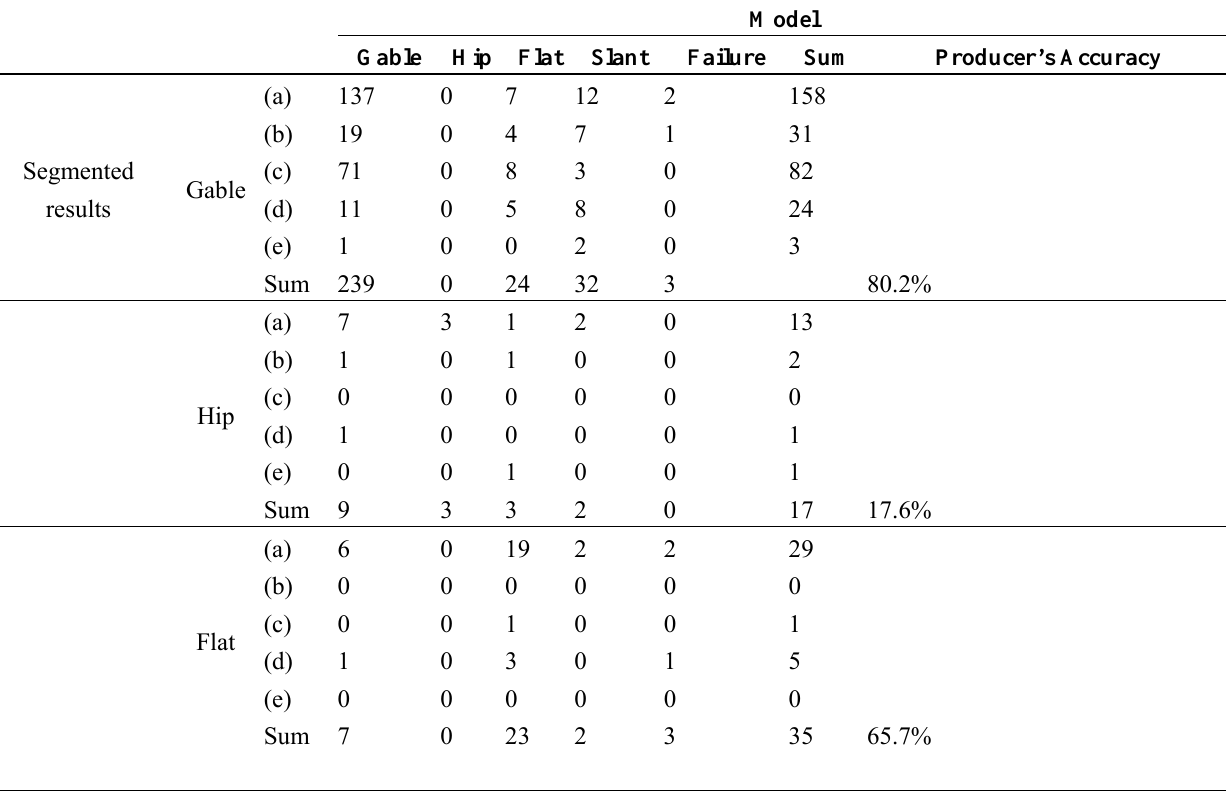
Table 4. Comparison between segmentation results and the model